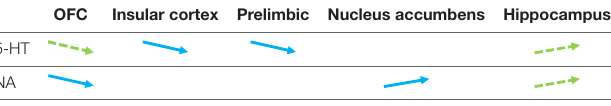
TABLE 1 | Statistical differences between risk-averse (blue, full arrow) and average mice and between risk-prone (green, dotted arrow) and average mice for basal levels of serotonin (5-HT), dopamine (DA) and noradrenaline (NA) in the orbitofrontal cortex (OFC), insular cortex, prelimbic, nucleus accumbens and